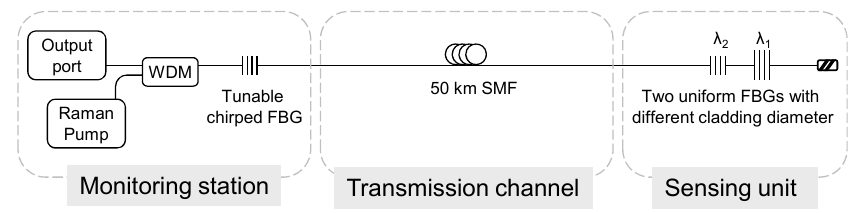
Figure 4. Experimental setup for the multiwavelength Raman fiber laser based on FBG located in serial configuration for a long distance remote-sensor system. Adapted from